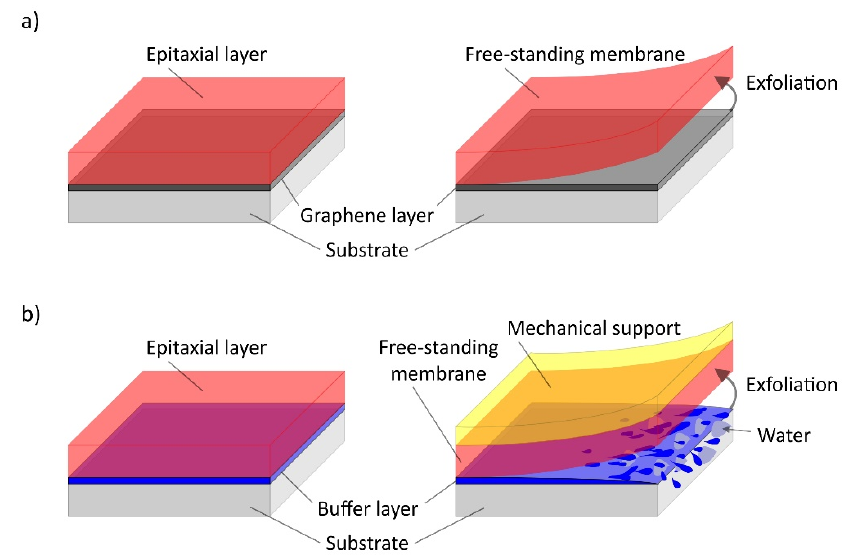
Figure 6. Approaches for transferring high-quality thin films. ( a ) Film and underlying substrate are separated by some weakly bonded graphene layers that transfer structural information. ( b ) Exfoliation after dissolution of an underlying water-soluble buffer layer and subsequent transfer using mechanical support.